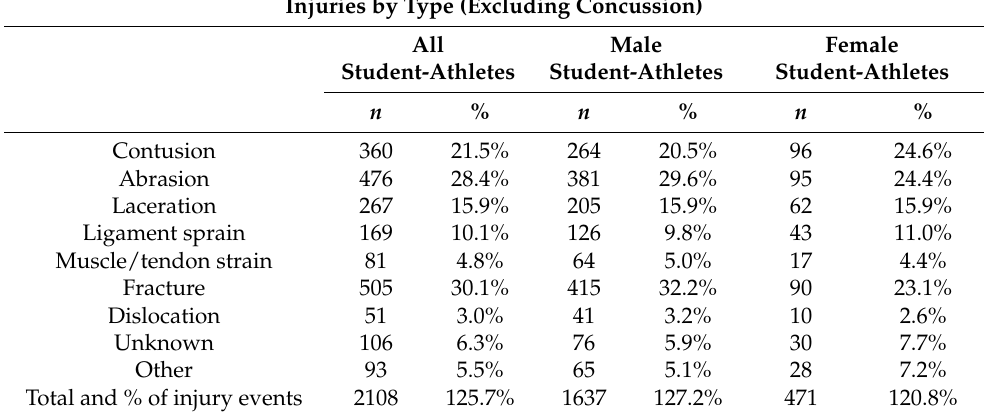
Table 2. Student athlete injuries by type, excluding concussion, n = 2108 injuries. Contusions and abrasions accounted for 39.7% of all non-concussion injuries in males and females collectively, while fractures and dislocations accounted for 26.4% of all non-concussion injuries. Total percentage exceeded 100% as multiple individual injuries can occur in a single injury event.